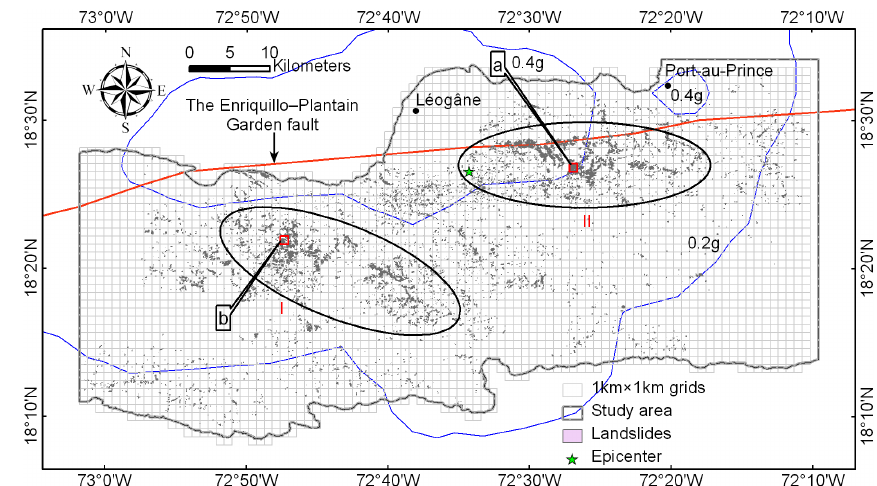
Figure 10. Spatial distribution of landslides triggered by the Haiti earthquake. Blue lines represent PGA contours downloaded from US Ge- ological Survey (2010). I and II are two landslide high density areas. We also constructed 1km × 1km grid cells (shown in gray). The red square (a) represents the grid cell with the highest value of landslide number density and landslide area percentage, and (b) represents the grid cell with the highest value of landslide erosion